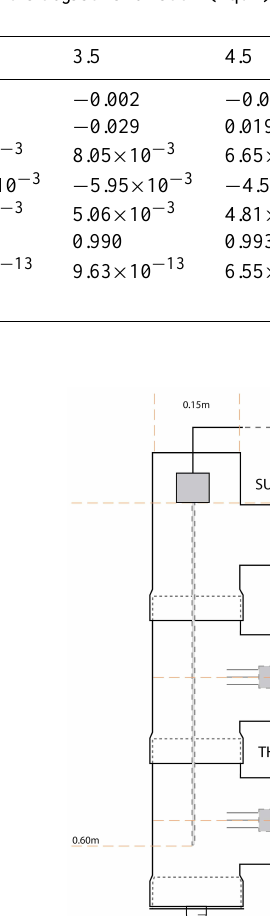
Table 4. Difference of inverted soil moisture to point measurements with 1 THETA probes as absolute error (AE) of the soil moisture in m 3 m − 3 ; goodness of fit criteria calculated from observed and reconstructed reflectograms: root mean square error (RMSQ), mean error